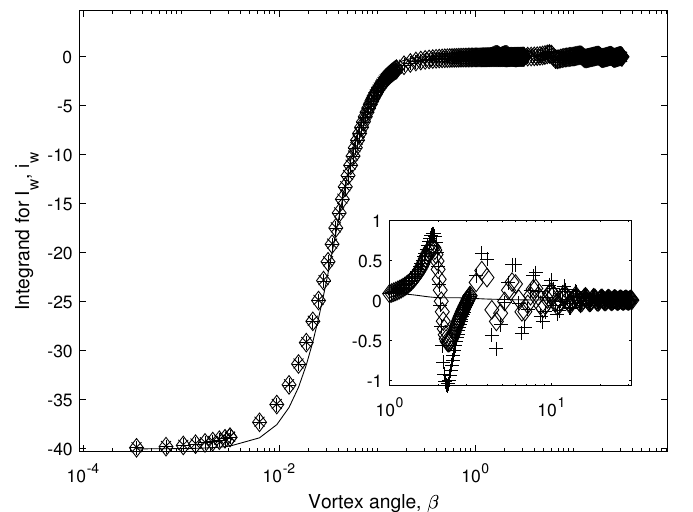
Figure 3. Integrand for I w for N = 3, p = 0.1, λ = 7.13 and r = 0.95. i w from Equation (12) for all blades, ; for Equation (12) and first blade only, + ; for Equation (17) and all blades, × shows i w from Equation (19).